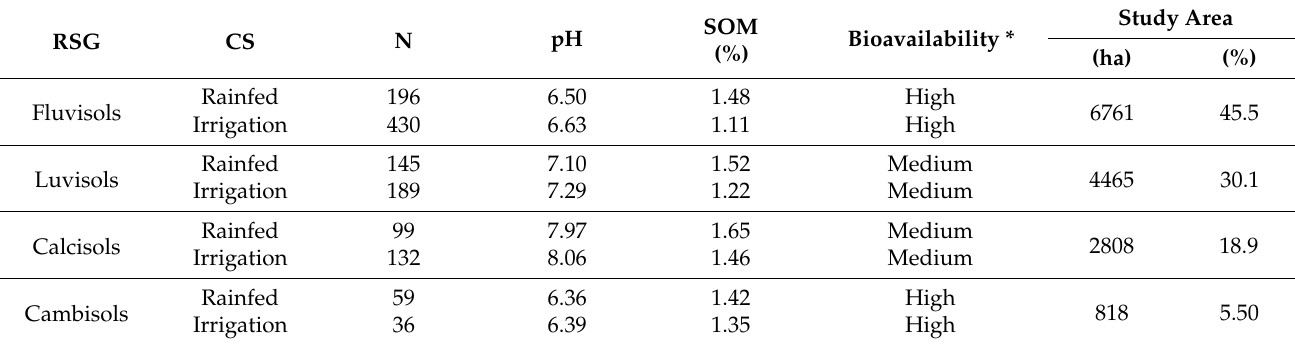
Table 3. Bioavailability of metal cations in uncontaminated soils for plants and soil invertebrates, depending on soil pH and